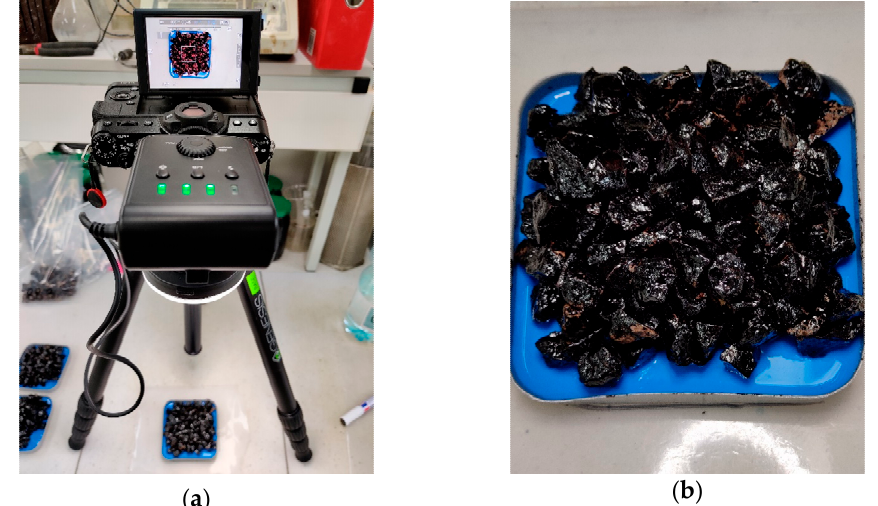
Figure 2. Acquisition of digital images: ( a ) setup used for the digital imaging; ( b ) sample prepared for digital imaging.